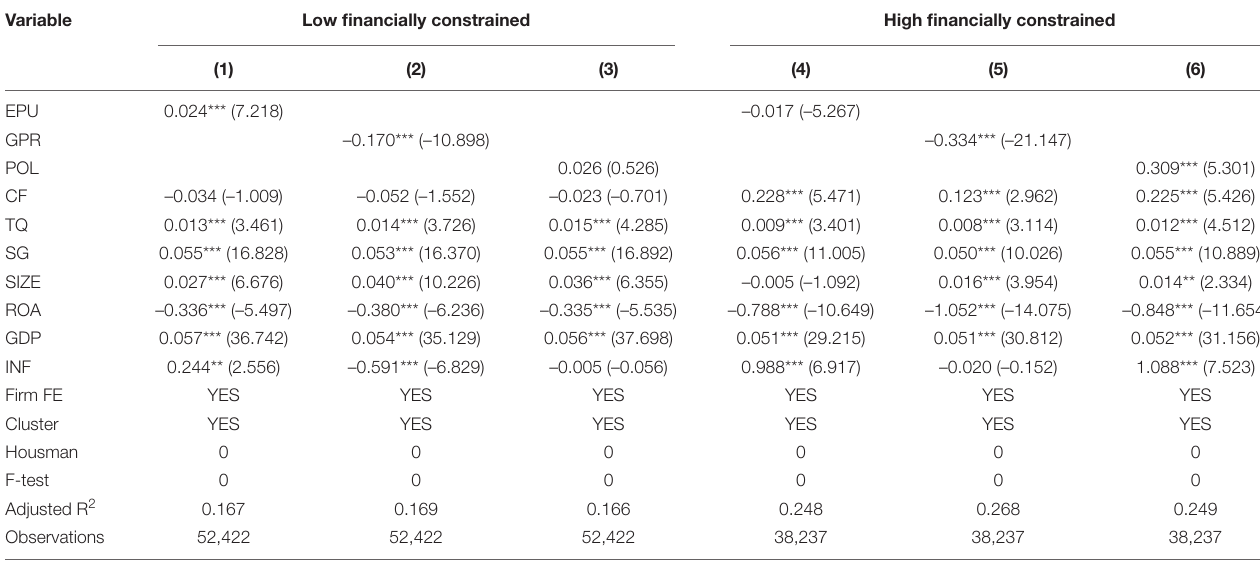
TABLE 6 | Robust checks: low financially constricted and high financially constricted